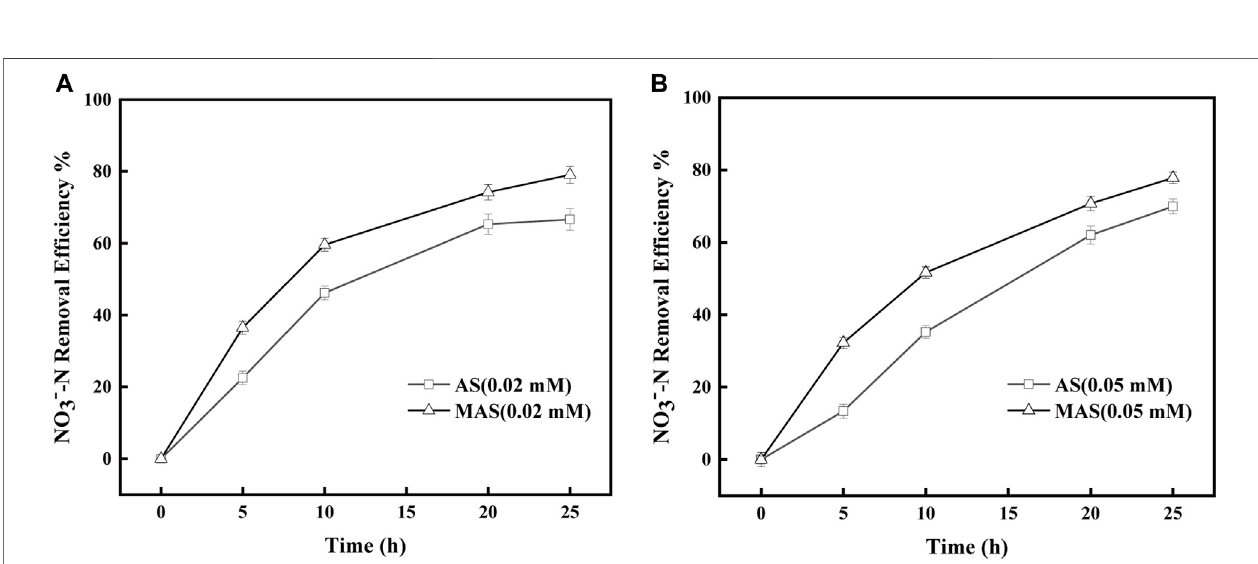
FIGURE7| EffectofnFe 3 O 4 ontherotenone-inhibitedrespiratorychainindenitri fi cation.Rotenoneconcentrationswere (A) 0.02 mMand (B) 0.05 mM,andNO 3 − - N was used as the fi nal electron acceptor.